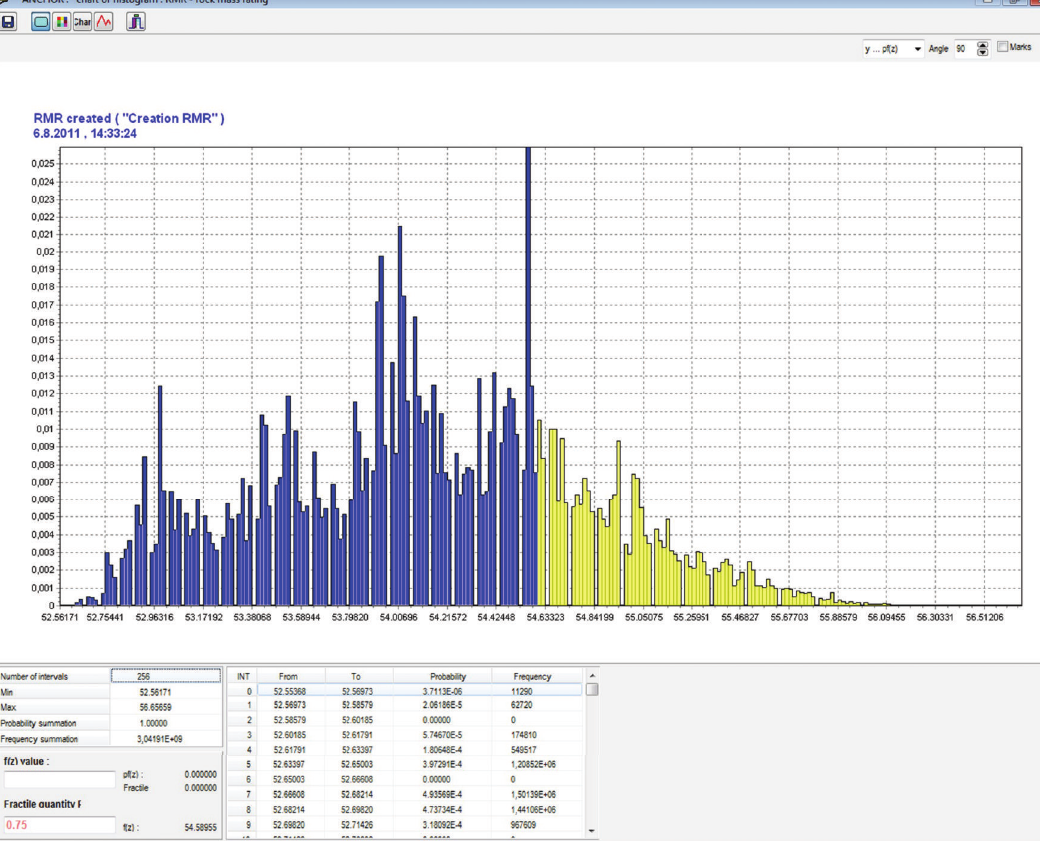
Figure 10: Histogram of rock mass rating (the geomechanical classification coefficient RMR)